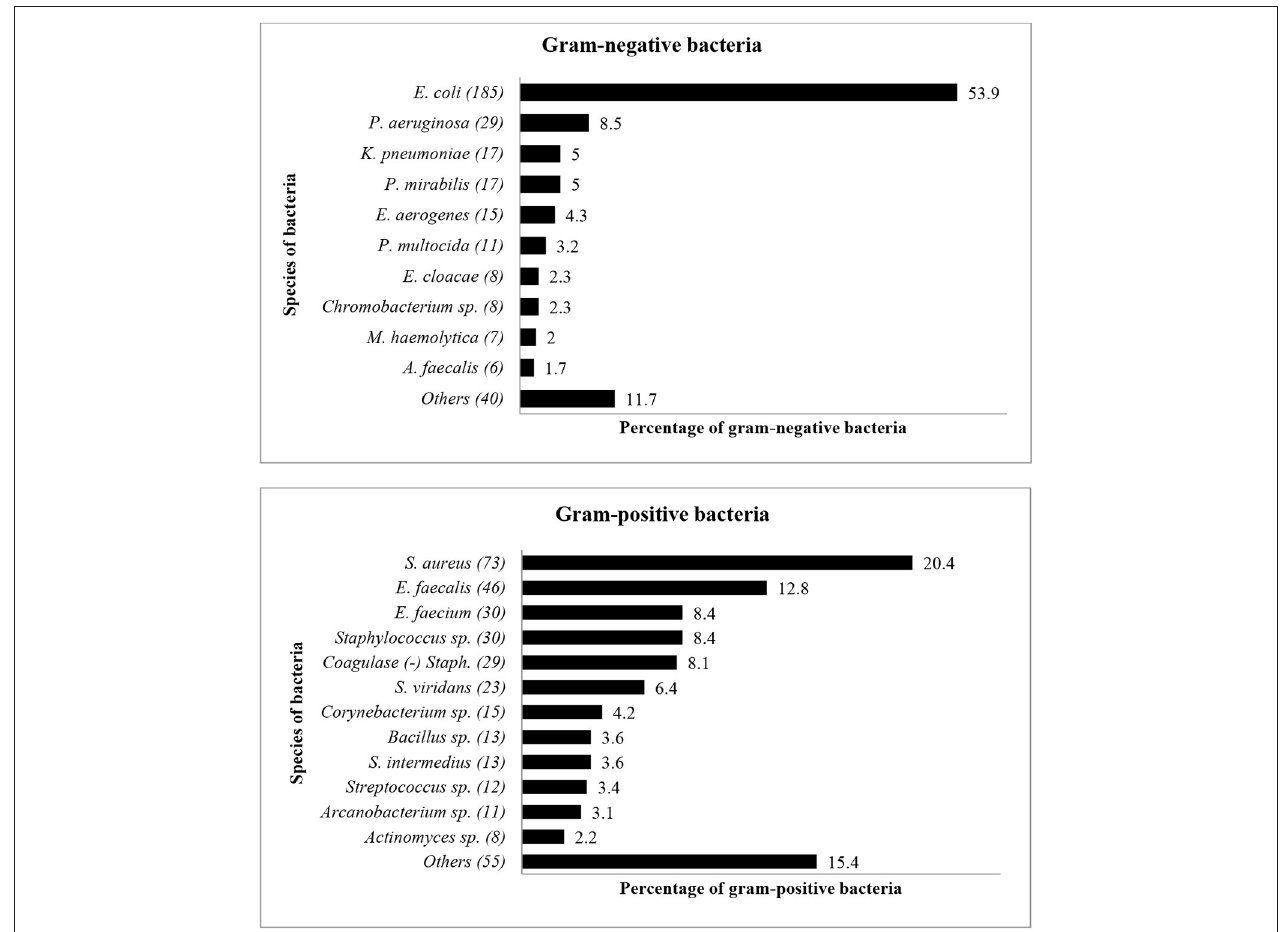
FIGURE 1 | The distribution of bacterial species (Gram-negative and Gram-positive) from diseased livestock isolated between January 2015 and December 2017. Numbers inside brackets “()” indicate total number of bacterial isolates. non-ruminants ( n = 301, 42.9%). The specimens were from wounds/abscess ( n = 112, 28.4%), post mortem ( n = 109,